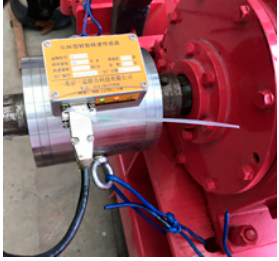
Figure 6. Installation of torque sensor .